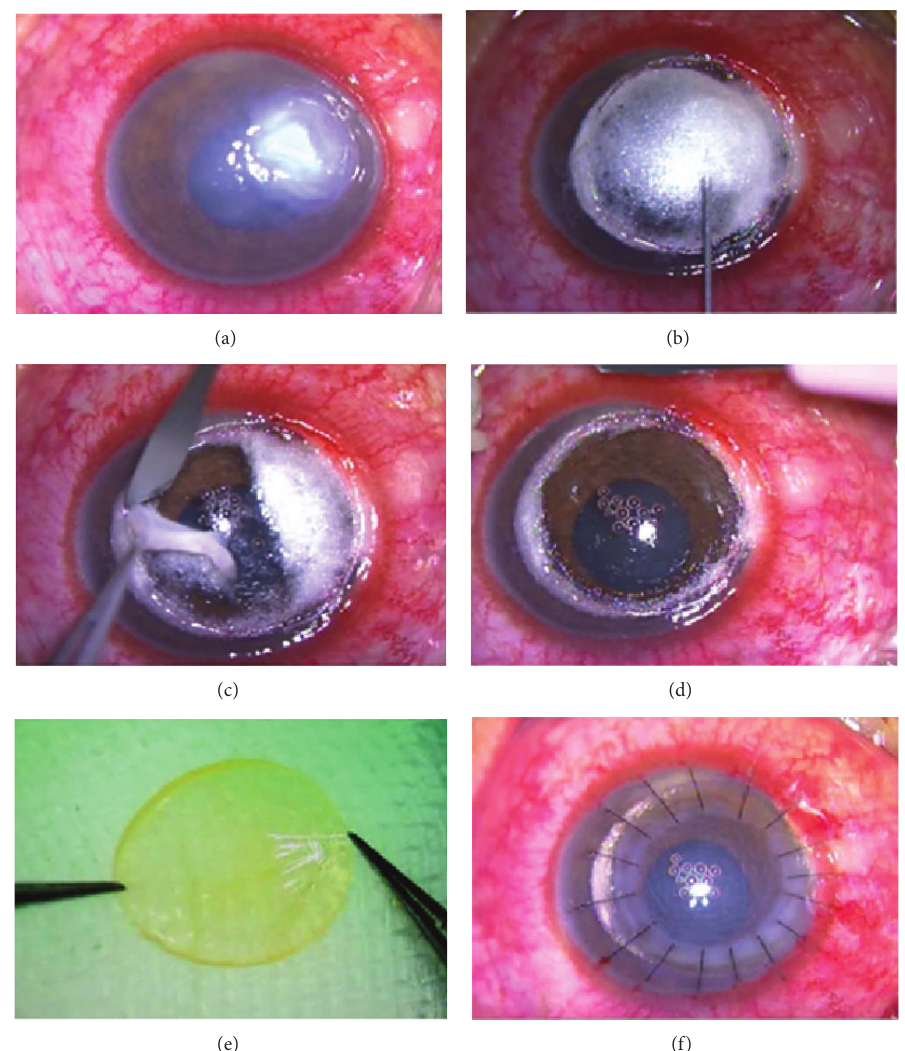
Figure 1: Surgical procedure of deep anterior lamellar keratoplasty for deep fungal keratitis. (a) Deep fungal ulceration with hypopyon before surgery. (b) A big bubble formed after 1.5 mL sterilized air is injected into the posterior stroma. (c) Debulking of the posterior stroma is performed with a 45 ∘ micro knife. (d) Descemet membrane is bared after the diseased stoma was cut off. (e) The donor Descemet membrane and endothelium are stripped off using 0.12 mm untoothed forceps. (f) The donor cornea is sutured to the recipient with 16 interrupted 10/0 nylon